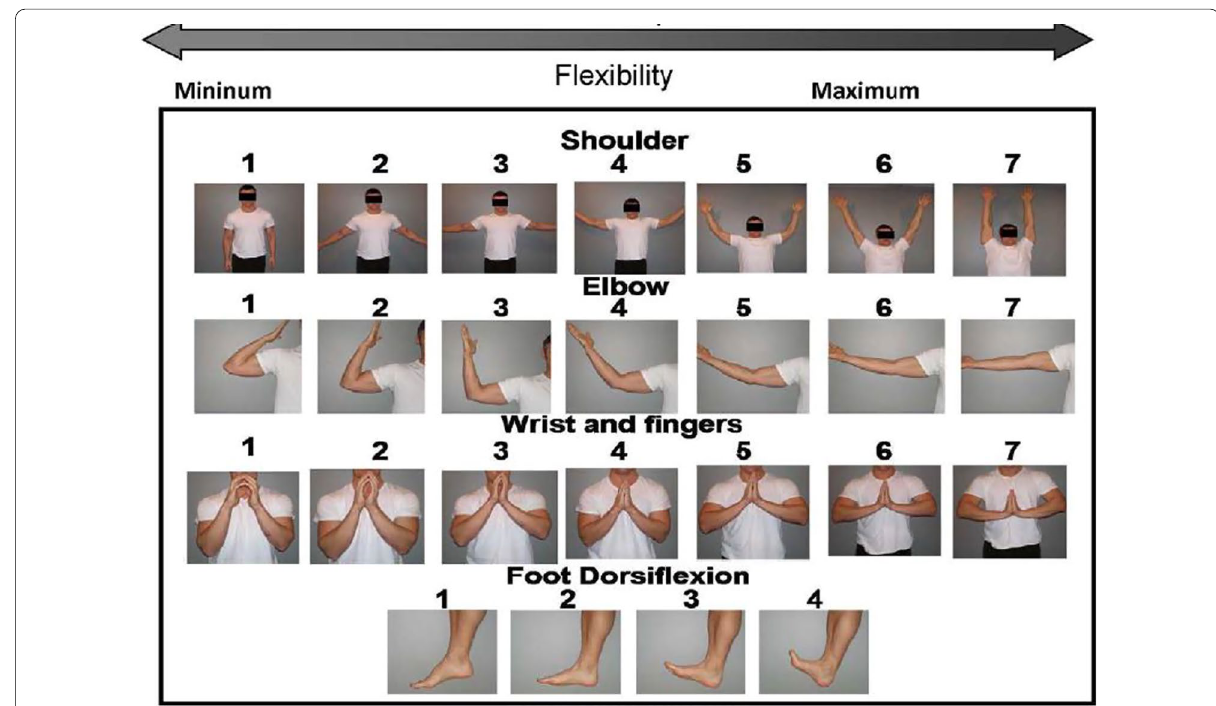
Fig. 1 Photographic range of motion: P‑ROM scale. Series of images that captures ROM separately for shoulders, elbows, wrists/fingers, and ankles. Lower scores indicate more limited ROM. The P‑ROM total score is the sum of scores in all 4 joints for a maximum of 25